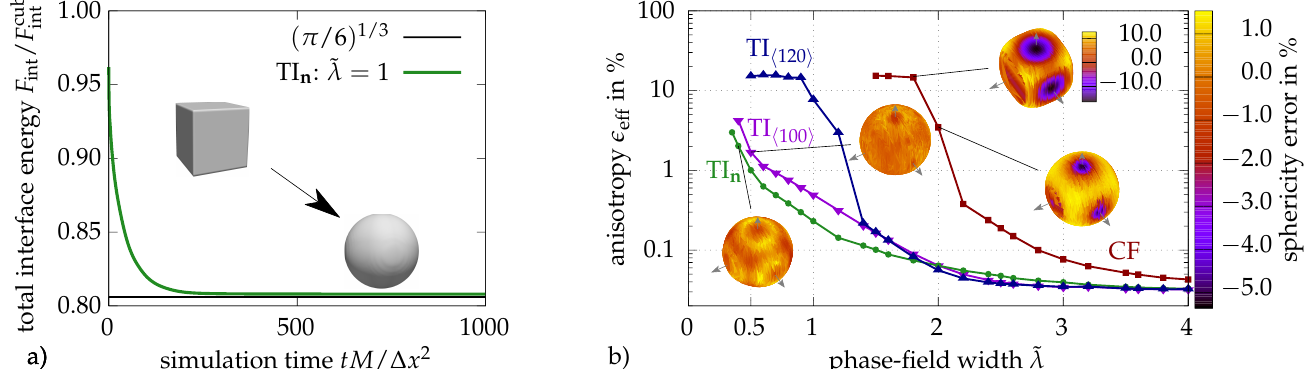
Figure 9. Investigation of the residual energetic anisotropy by interface energy relaxation of an initially cubic particle at constant particle volume. ( a ) Total interface energy as a function of the simulation time. ( b ) Anisotropy (cid:101) eff = ( R max − R min ) /2 R mean of the final quasi-equilibrium phase- fields as a function of the phase-field width ˜ λ for different phase-field models. Insets: Phase-field contours together with their sphericity errors plotted as color-value. For ˜ λ = 1.8, the extended error range is plotted aside from the